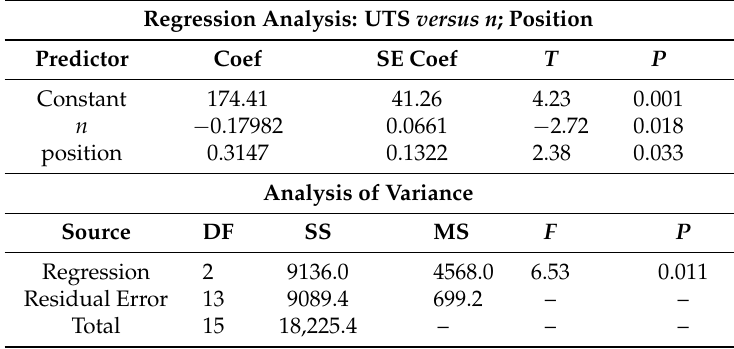
Table 8. Surface Plot of UTS vs. rotation speed ( n ) and position.